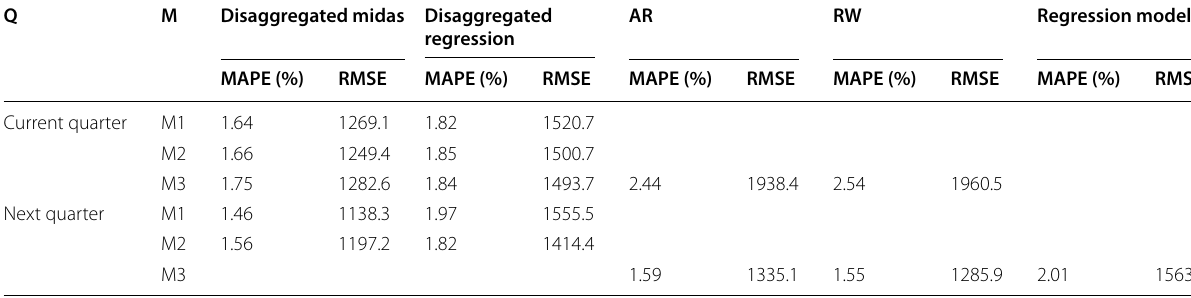
Table 16 MAPE and RMSE loss functions for the disaggregated GDP models with error correction forecast Q M Disaggregated midas Disaggregated AR regression